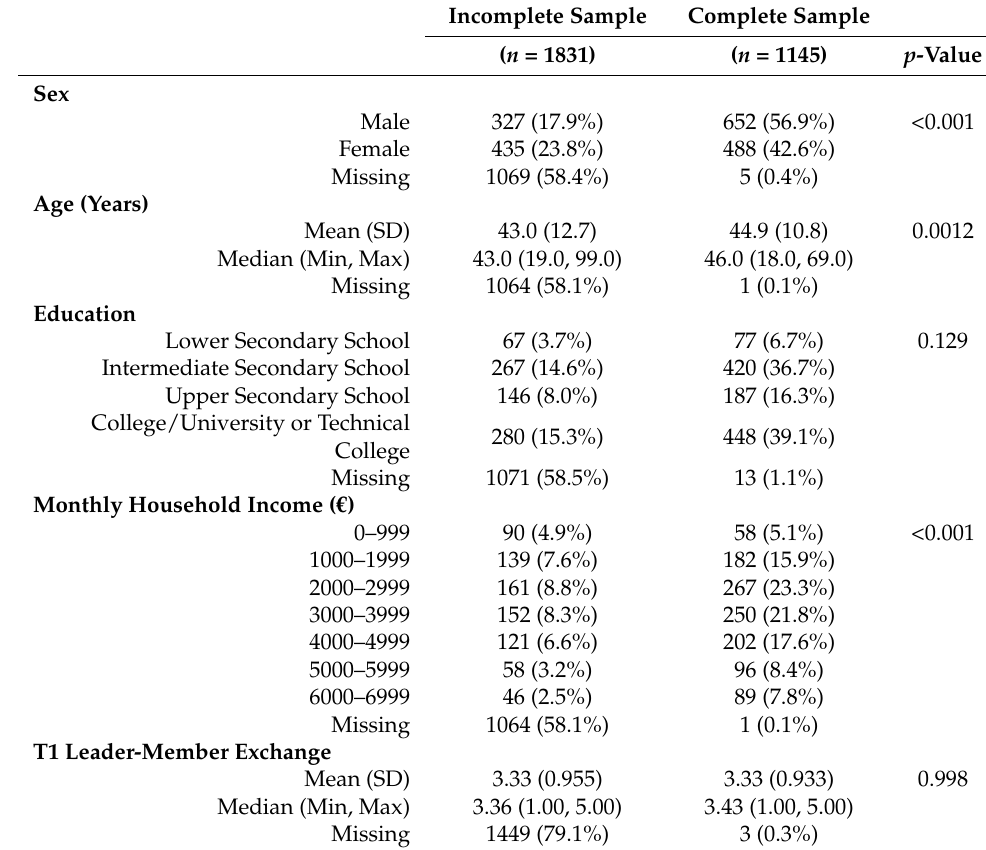
Table 1. Demographics and Descriptive